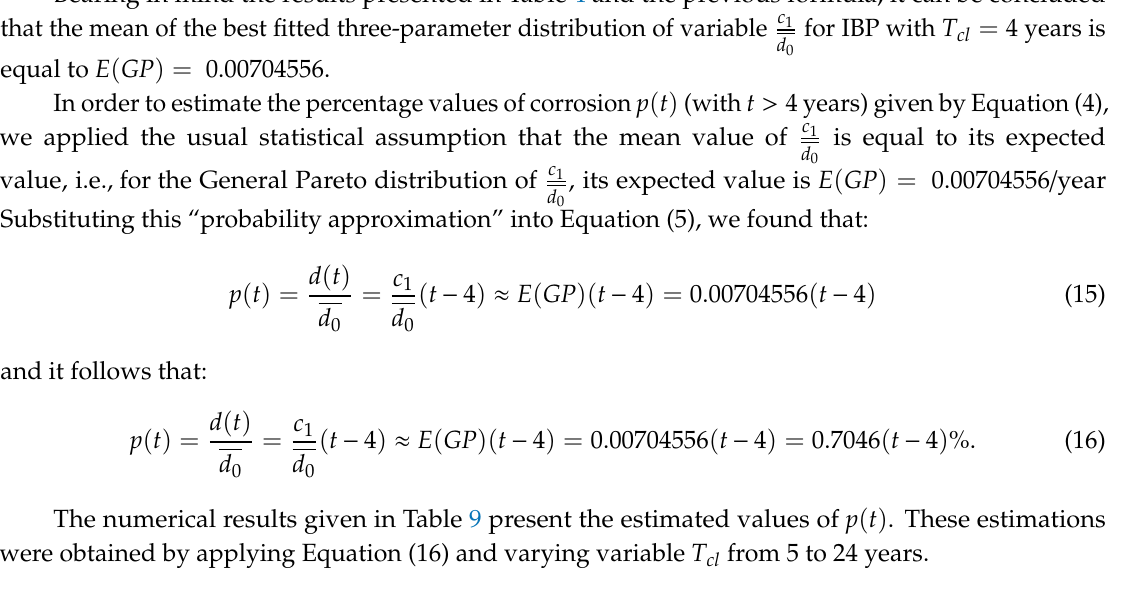
( t ) for IBP with T cl > 4 years (expressed as a percentage) in d 0